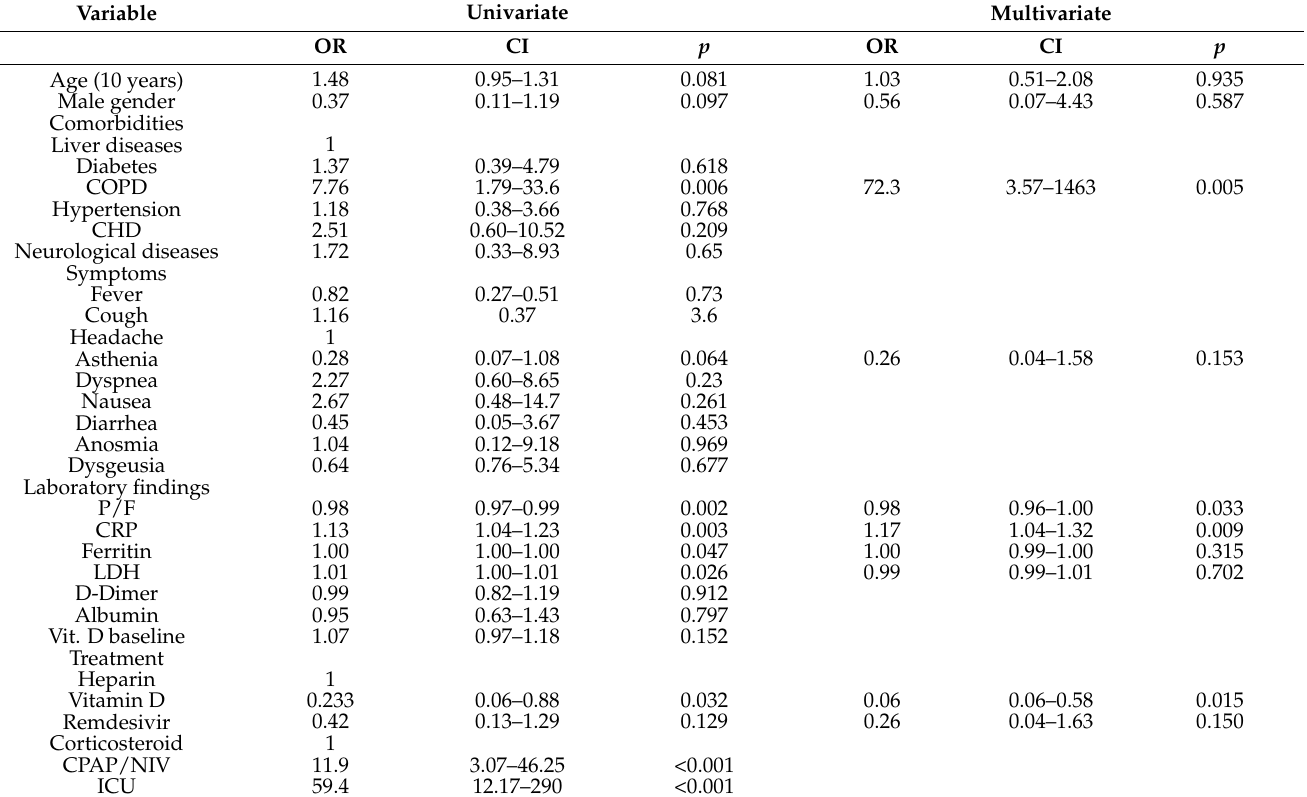
Table 3. Logistic regression analyses on variables influencing